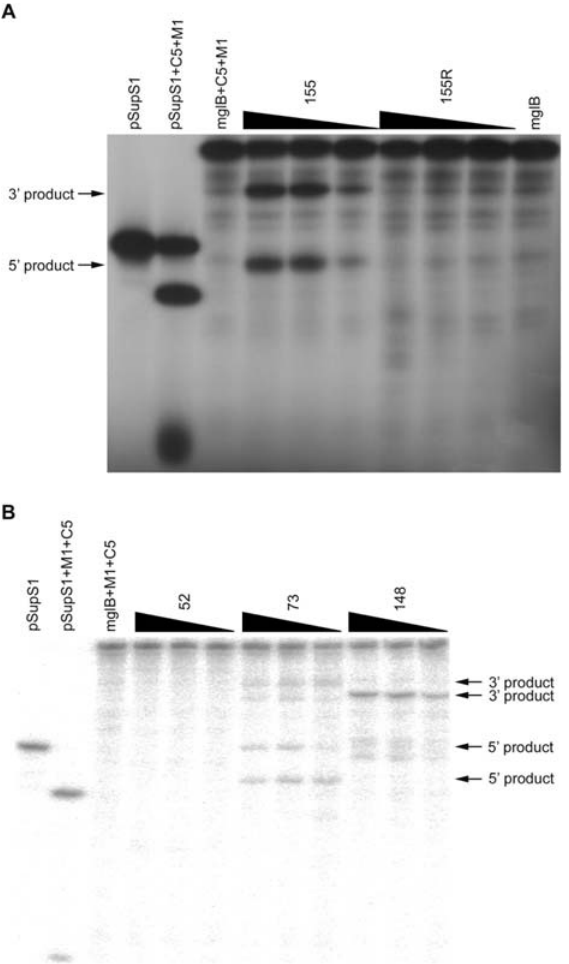
Figure 3. Cleavage invitro of the mglB mRNA by the M1 EGSs alone in the presence of high MgCl 2 concentration. A. Activities of M1 EGS155. B. Activities of M1 EGS52, M1 EGS73, and M1 EGS148. The RNase P holoenzyme was reconstituted by 10 nM M1 RNA and 100 nM C5 protein. If M1 EGS or M1 RNA was added in the absence of the C5 protein, additional 90 mM MgCl 2 was added. The mglB mRNA cleavage products were separated on 8% polyacrylamide/7 M urea gels together with the mglB mRNA alone or the mglB mRNA with M1 and/or C5 components of the RNase P holoenzyme. Internally labeled pSupS1 ptRNA was used as a positive control to check for activity of the reconstituted RNase P holoenzyme or M1 RNA alone in the presence of high MgCl 2 concentration. Stem EGS155 and M1 EGSs (M1 EGS52, M1 EGS73, M1 EGS148, or M1 EGS155) were added in 10-, 50- or 100-fold molar excess to mglB mRNA, denoted by black